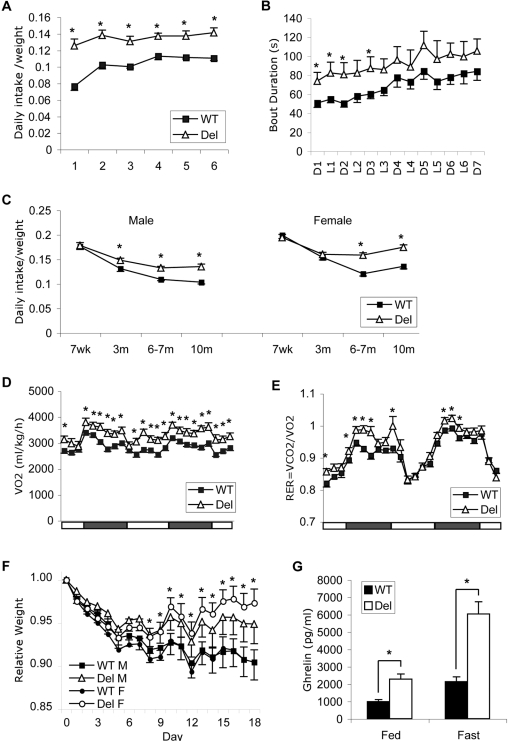

 Snord116del mice are hyperphagic and have altered metabolism.A. Daily food intake during 6 days in Oxymax metabolic chambers was normalized to body weight (n = 8 WT, 7 Del, all points P<0.05). Error Bars: SEM. B. Average feeding bout duration of the same group of mice as in (A) during each 12 hr cycle. D, dark cycles; L, light cycles. Asterisks indicate P<0.05. C. Daily food intake at different ages. Daily food intake was averaged over 5–7 consecutive days and normalized to body weight of each individual. At 7 week, males n = 16 both genotypes; females, n = 15 WT, 11 Del; at 3 months, males n = 13 WT, 9 Del, P<0.04; females n = 12 WT, 12 Del; at 6–7 months, (males n = 15 both genotypes, P<2 ×10−6; females n = 14 WT, 16 Del, P<3 ×10−6, and at 10 months males n = 21 WT, 19 Del, P<3 ×10−5; females n = 13 both genotypes, P<2 ×10−5. D. Oxygen consumption rates (averaged over 2 hr time periods) on the second and third day in the metabolic chamber (n = 15 both genotypes). Bars at bottom indicate light and dark cycles. Asterisks, P<0.05. E. Respiratory exchange rate (RER) averaged over 2 hr time periods for the same group of mice as in (D) during the same time in the metabolic chamber. Asterisks, P<0.05. F. Weight change in mice food-restricted to 80% their normal daily intake. Males (n = 11 both genotypes) and females (n = 13 both genotypes) at 11 months of age. Asterisks indicate significant difference between WT and Del females with P<0.05. G. Snord116del mice have increased ghrelin levels. Plasma ghrelin levels were measured in ad lib fed mice at 11 months of age (n = 12 both genotypes; P<0.002) and 24 hr fasted mice (n = 13 both genotypes ; P<0.0002)